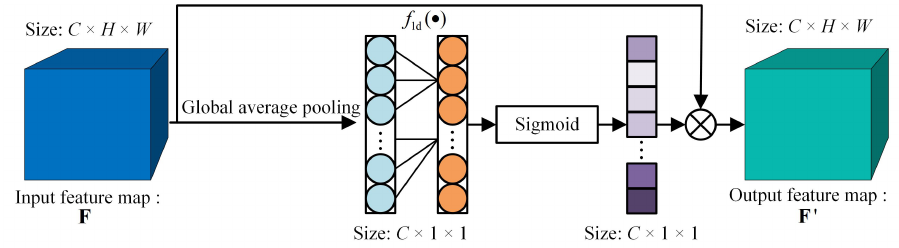
Figure 5. ECA channel attention